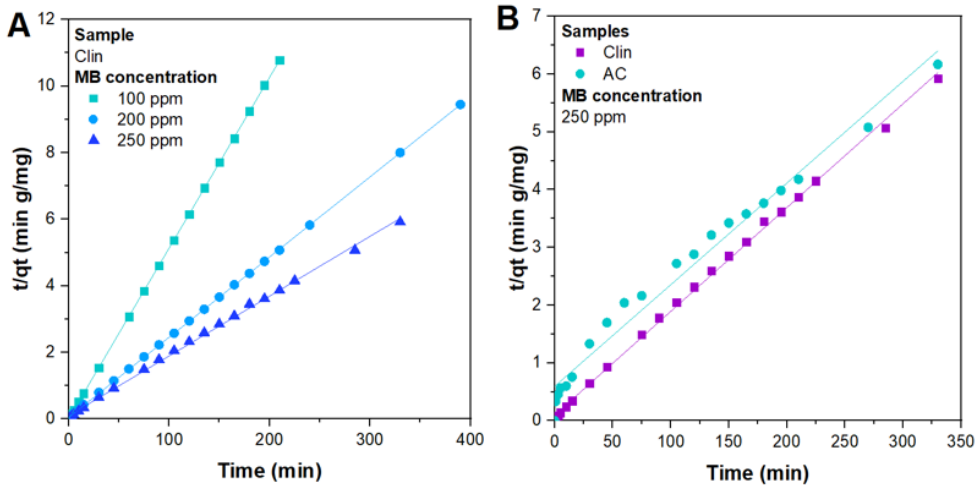
Figure 7. Experimental data of MB abatement tests fitted with a PSO kinetic model with different concentrations of MB on Clin ( A ) and by using 250 ppm MB on Clin and AC ( B ). Table 4. Kinetic parameters of MB abatement using Clin and AC as adsorbents.